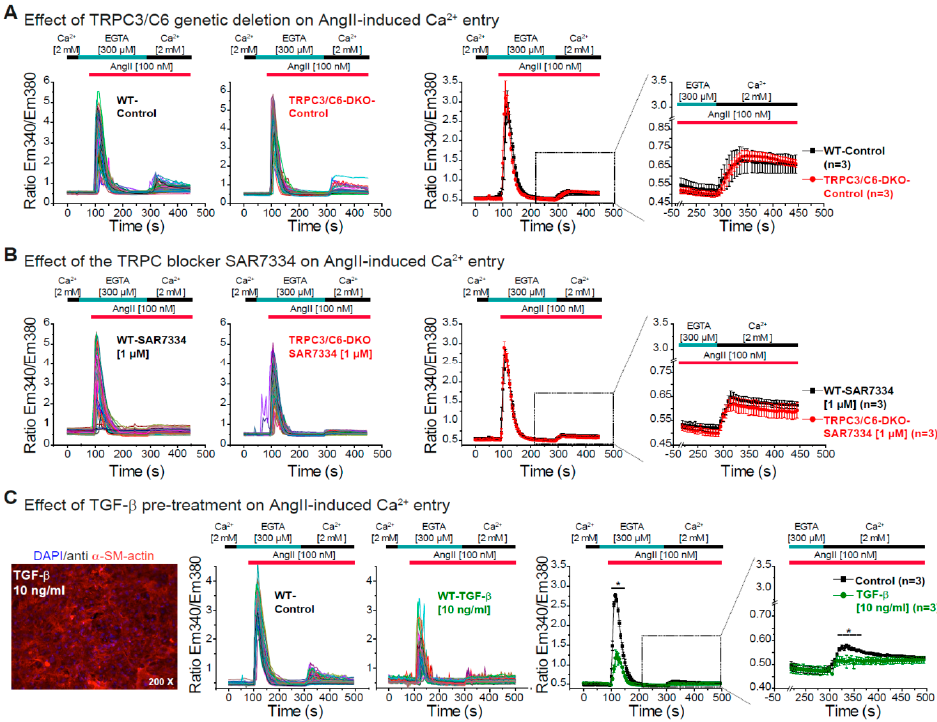
Figure 3 . AngII-induced Ca 2+ release and Ca 2+ entry in the absence of TRPC3/C6 or after TGF- β pre-treatment. ( A ) AngII-induced Ca 2+ release and Ca 2+ entry in primary CFs from WT (black) and TRPC3/C6-DKO (red) mice. Ca 2+ release was measured in the absence of extracellular Ca 2+ (300 µM EGTA) and Ca 2+ entry was monitored in the presence of 2 mM extracellular Ca 2+ . Left panels: Original traces and right panels: Mean values from three independent preparations (hearts). ( B ) Measurements performed as in (A) but in cells pre-incubated (10 min) with the TRPC3/C6/C7 antagonist SAR7334 (1 µM). ( C ) AngII-induced Ca 2+ release and Ca 2+ entry in primary CFs from WT mice cultivated in the presence of 10 ng/mL TGF- β (green) or under control conditions (black). Left panel: α -actin smooth muscle staining after TGF- β treatment, middle panels: Original traces from Ca 2+ measurements and right panels: Mean values from 3 independent preparations. n = number of independent preparations (hearts). All cells were analyzed 5 days after isolation and were cultured at high density. * p < 0.05 according to the unpaired Student’s t -test.